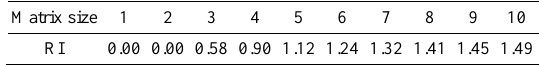
Table 1. Random Consistency Index values Matrix size